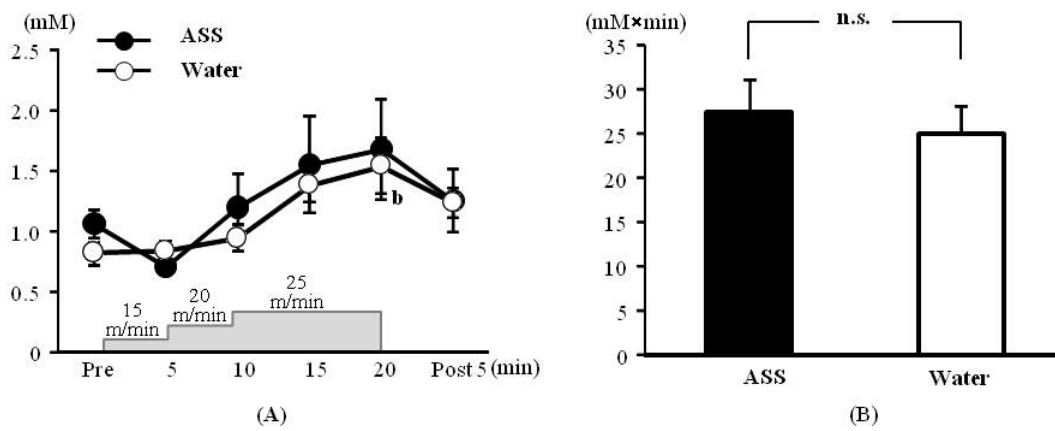
Figure 1. Changes in the blood lactate on incremental treadmill exercise. ( A ) time course change, x axis: elapsed time on running, y axis: blood lactate concentration ( B ) area under the curve of blood lactate acid, x axis; group, y axis: total volume of blood lactate. Values are expressed as mean ± SE. b: significant difference from pre ( p < 0.01). n.s.: